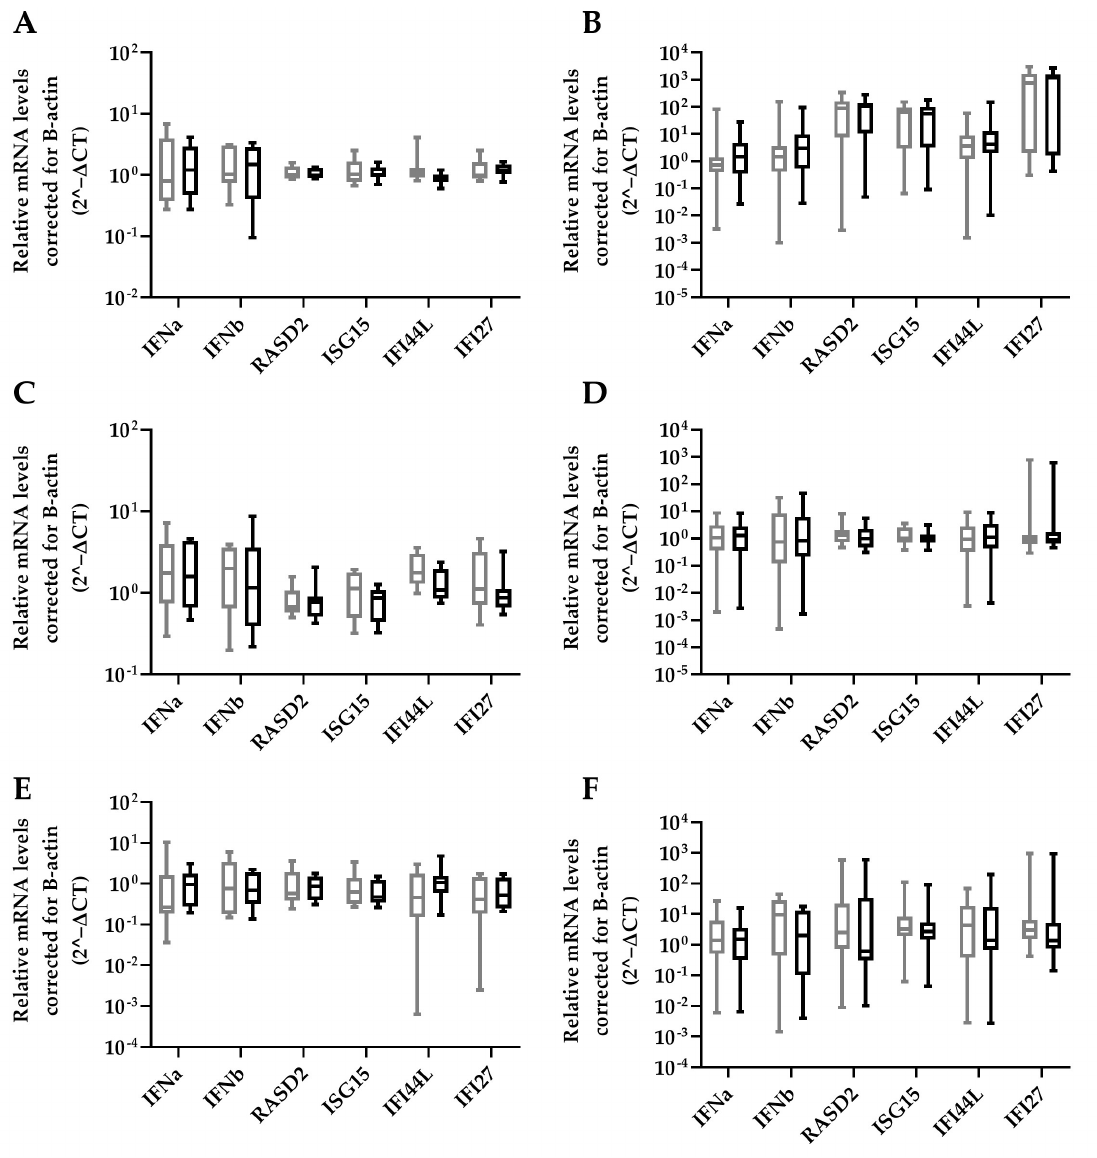
Figure 5. Effect of HBV-miR-6 on innate signaling. HepG2 cells were transduced with a lentiviral vector expressing GFP (grey) or HBV-miR-6 (black). After 48 h, the cells were stimulated with either IFNa ( A , B ), R848 ( C , D ) or ODN2216 ( E , F ). The expression levels of IFNa, IFNb, and ISGs (RASD2, ISG15, IFI44L, IFI27) were measured using qPCR at 6 h ( A , C , E ) or 16 h ( B , D , F ) after stimulation. Relative expression levels of mRNA were normalized to B-actin expression using the 2ˆ − ∆ Ct method and groups were compared using a Mann–Whitney U test. Data are presented as a boxplot and whiskers; graphs represent averages of results from three independent